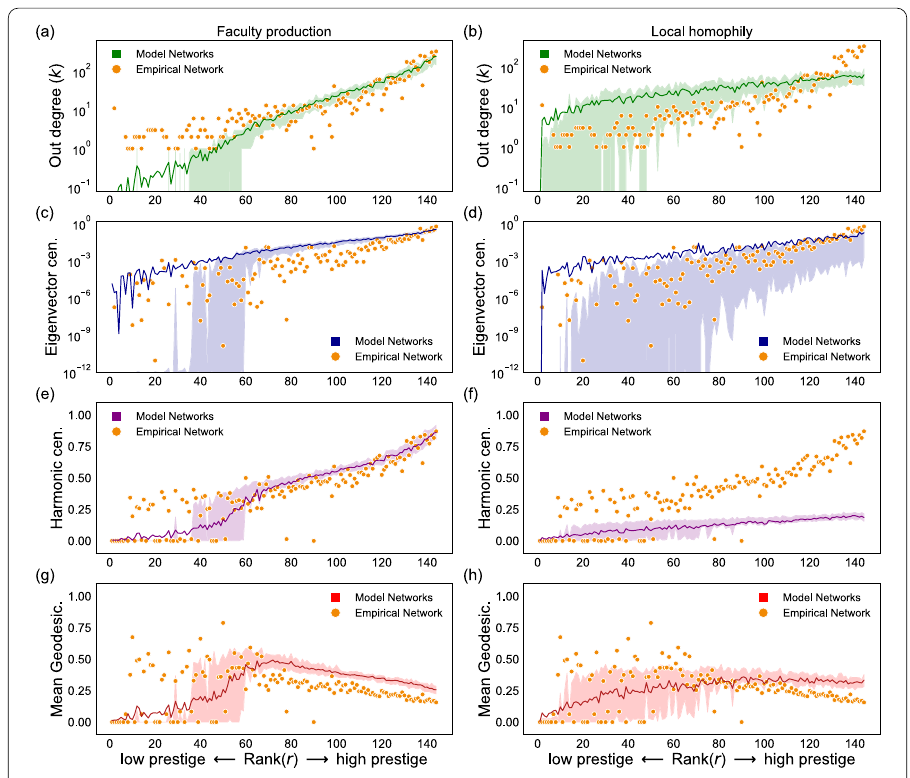
Figure S6 Structural patterns of hiring model networks for two mechanisms of Faculty production and Local homophily and the empirical History hiring network as a function of prestige. ( a ), ( b ) Out-degree k i , ( c ), ( d ) eigenvector centrality, ( e ), ( f ) harmonic centrality, and ( g ), ( h ) mean geodesic distance normalized by network diameter. Panels on the left ( a ), ( c ), ( e ), ( g ) show results for the Faculty production model, and panels on the right ( b ), ( d ), ( f ), ( h ) show results for the Local homophily model (skewed initialization). Solid lines indicate the mean over 50 simulations, and shaded region around the mean indicates the 25% to 75% quantile range. Orange points indicate the observed values for the History hiring network. Large rank denotes higher